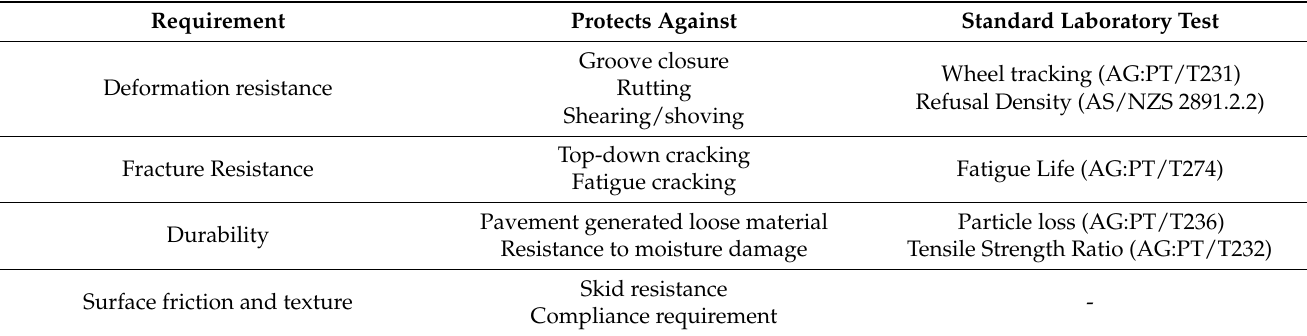
Table 1. Performance requirements and standard tests for airport asphalt